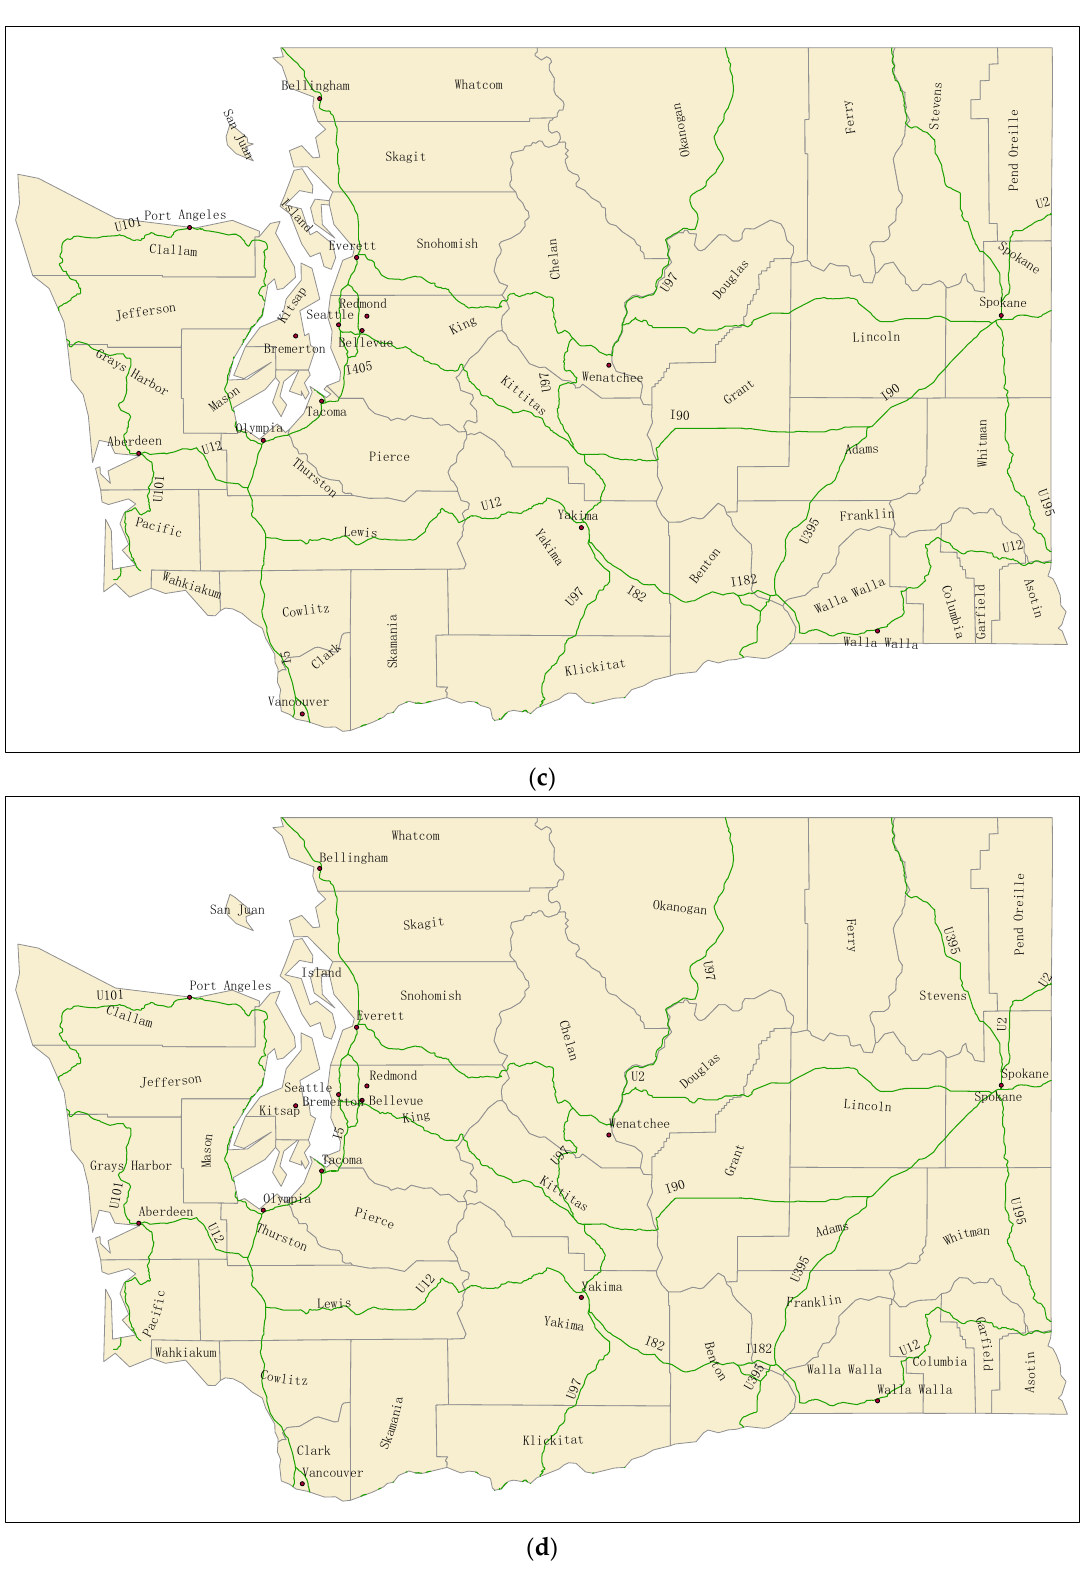
Figure 5. The map of Washington State with labels generated by four approaches: ( a ) GA; ( b ) DDE; ( c ) DDEGA; and ( d ) Maplex.